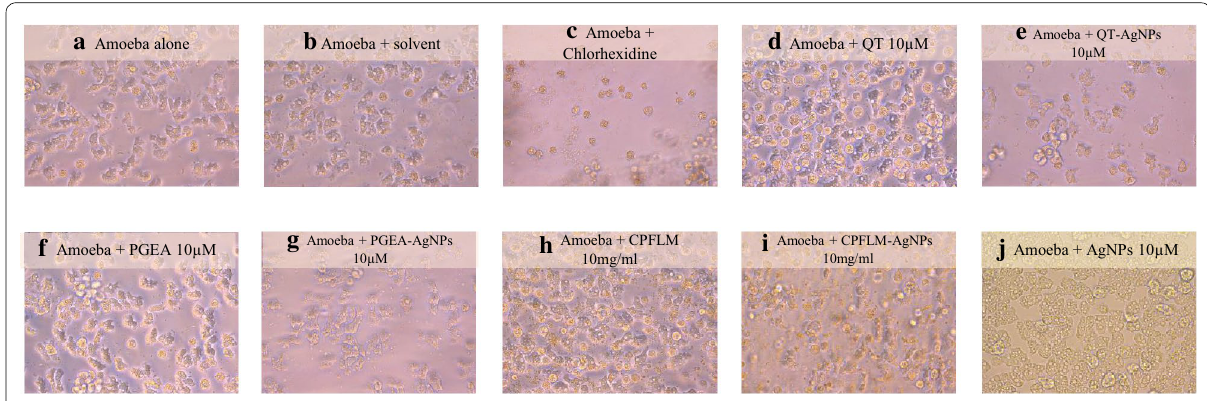
Fig. 4 Representative effects of naturals compounds and nanoconjugates on inhibiting the viability of A. castellanii . a Amoeba alone; b amoeba solvent control; c amoeba + amoeba